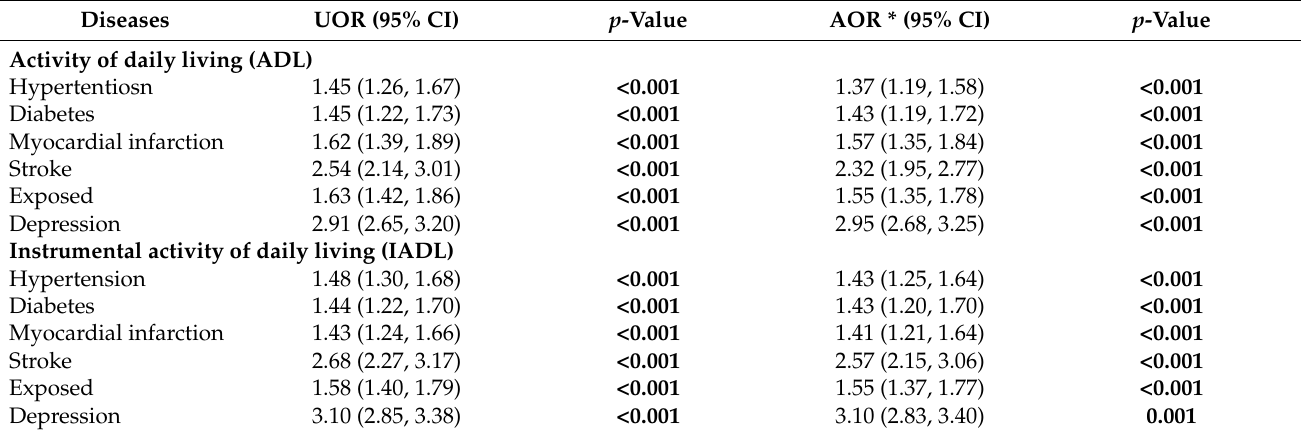
Table 4. The risk of functional impairment according to vascular disease—single